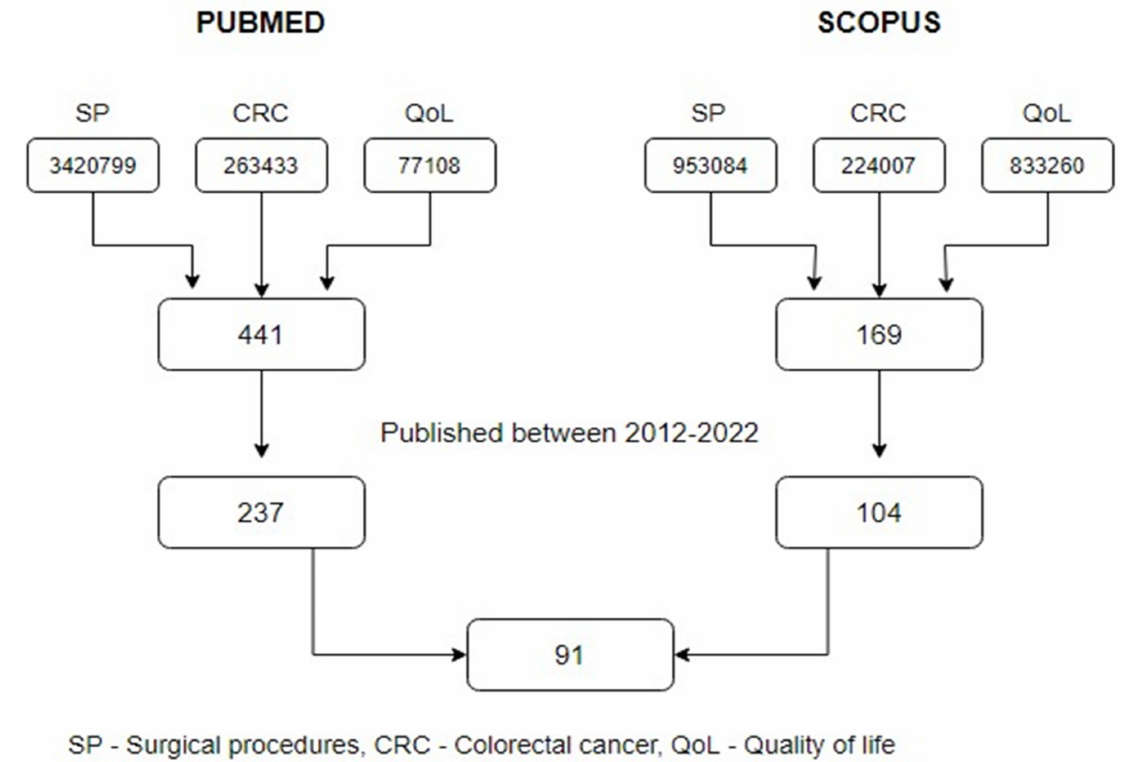
Figure 1. A schematic process for selecting publications for the